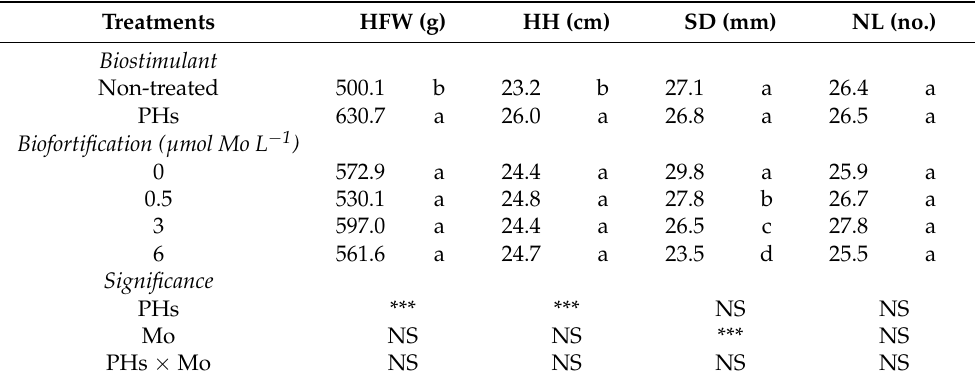
Table 1. Effect of PHs treatment and Mo-biofortification on head fresh weight (HFW), head height (HH), stem diameter (SD), and number of leaves (NL) of ‘Canasta’ lettuce cultivated in a protected